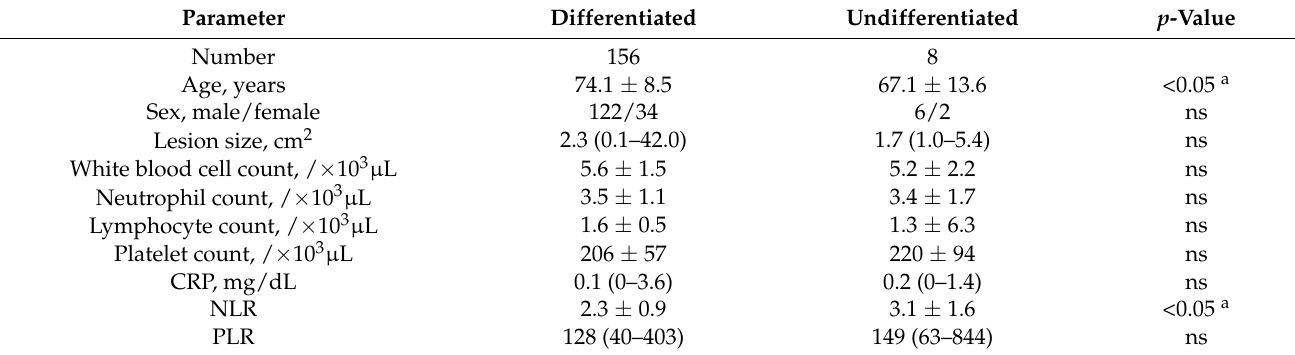
Table 2. Characteristics in patients with adenocarcinoma.